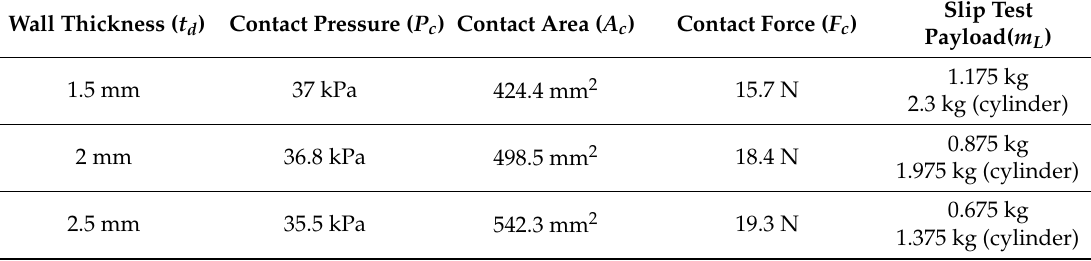
Table 2. Contact force and slip test results for varying wall thicknesses. Test object is a foam sphere unless stated otherwise in brackets.